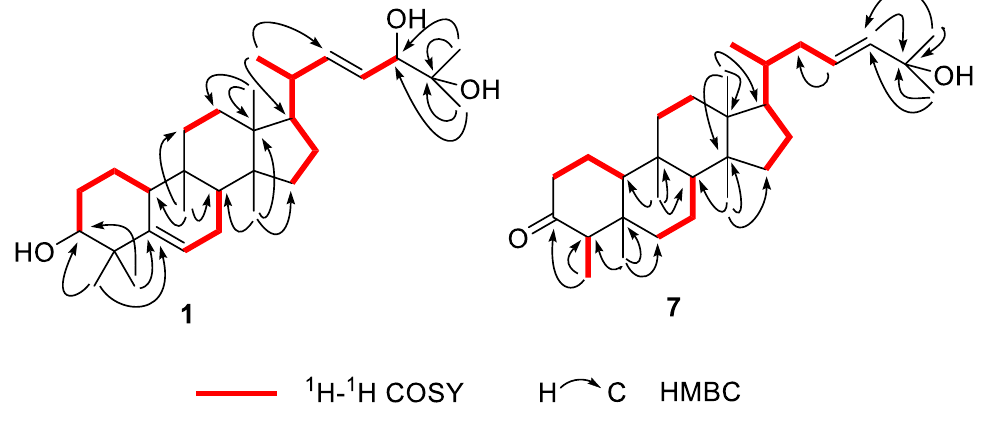
Fig. 2 Selected 1 H– 1 H COSY and HMBC correlations of 1 and 7